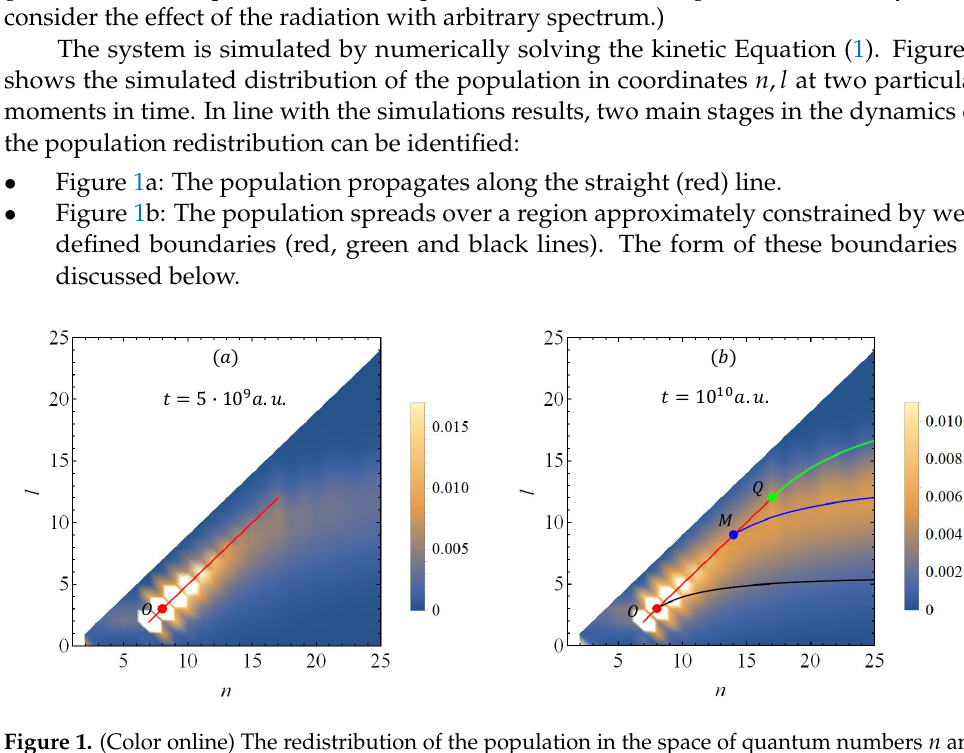
Figure 1. (Color online) The redistribution of the population in the space of quantum numbers n and l . The initial state is 8f. The incident radiation has a rectangular spectrum with ω min = 2 × 10 − 4 , ω max = 3 × 10 − 3 and a spectral density ρ = 4 × 10 − 14 ; ( a ) t = 5 × 10 9 a.u., ( b ) t = 10 10 a.u. The magnitude of the population is shown in color. The boundaries (5), (7) and (9) are shown by red, green and black curves, respectively; the main path (36) is shown by a blue line. Point O corresponds to the initial state, point Q corresponds to ω n ≈ ω min (6), (8), and point M is the point of deflection (31) of the main path from the red